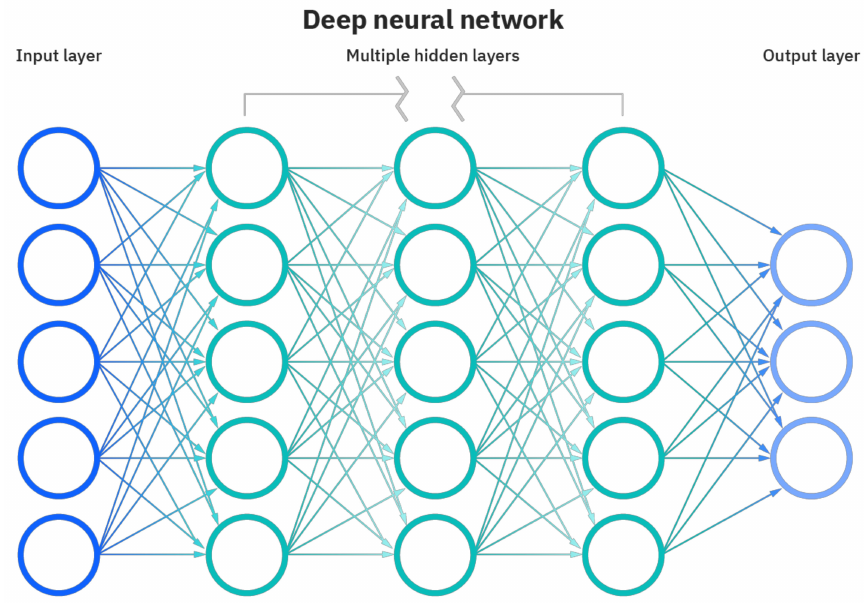
Figure 4. Deep neural